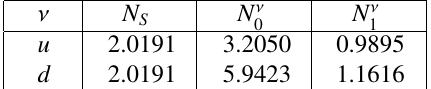
Table 4: Values of normalization constants N 2 to both up and down